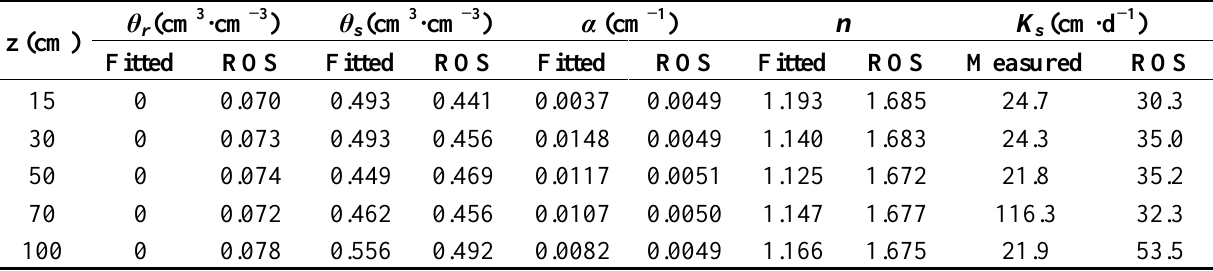
Table 4. Parameters used in